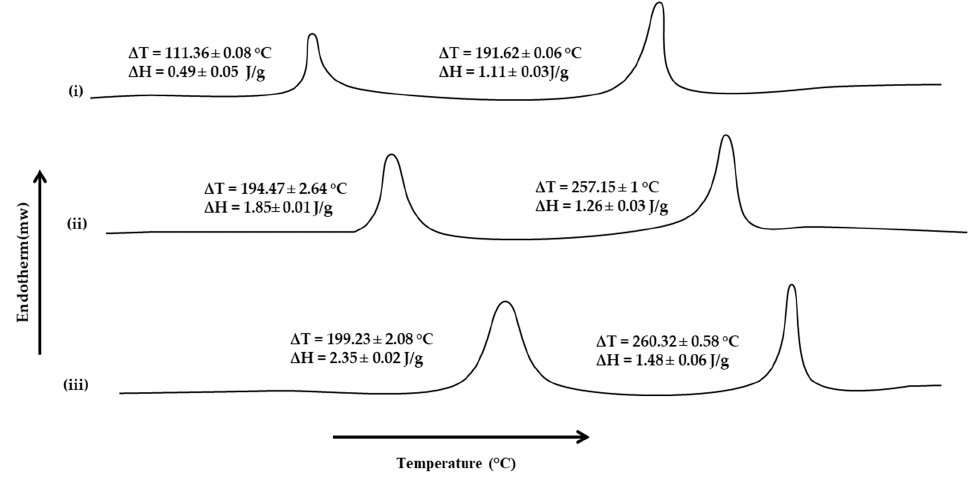
Figure 5. DSC thermograms of ( i ) UB, ( ii ) MB-1, and ( iii ) MB-3.